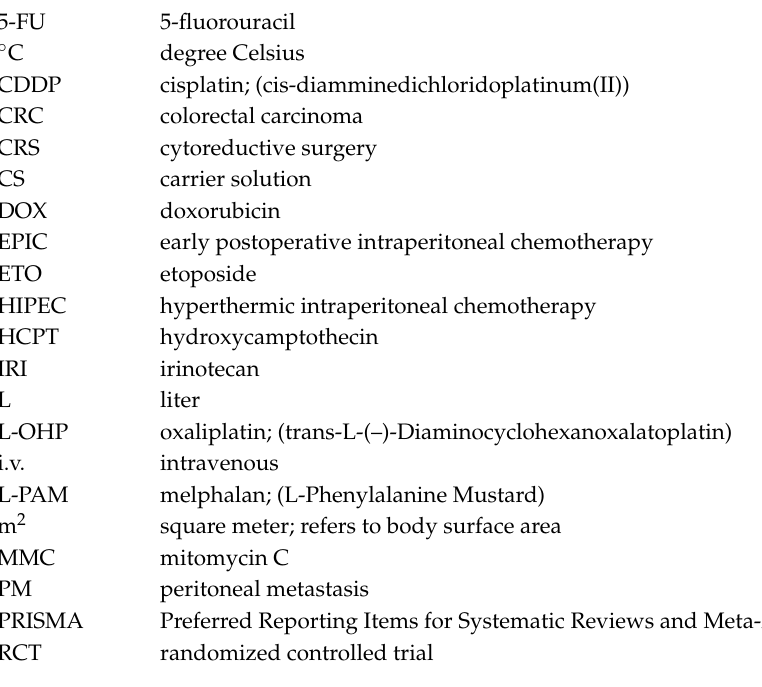
Table S7: Original data HIPEC protocols with rare drug combinations, Table S8: Original data HIPEC protocols with rare monotherapies, Table S9: Original data concomitant i.v. chemotherapy during HIPEC; Table S10: PRISMA